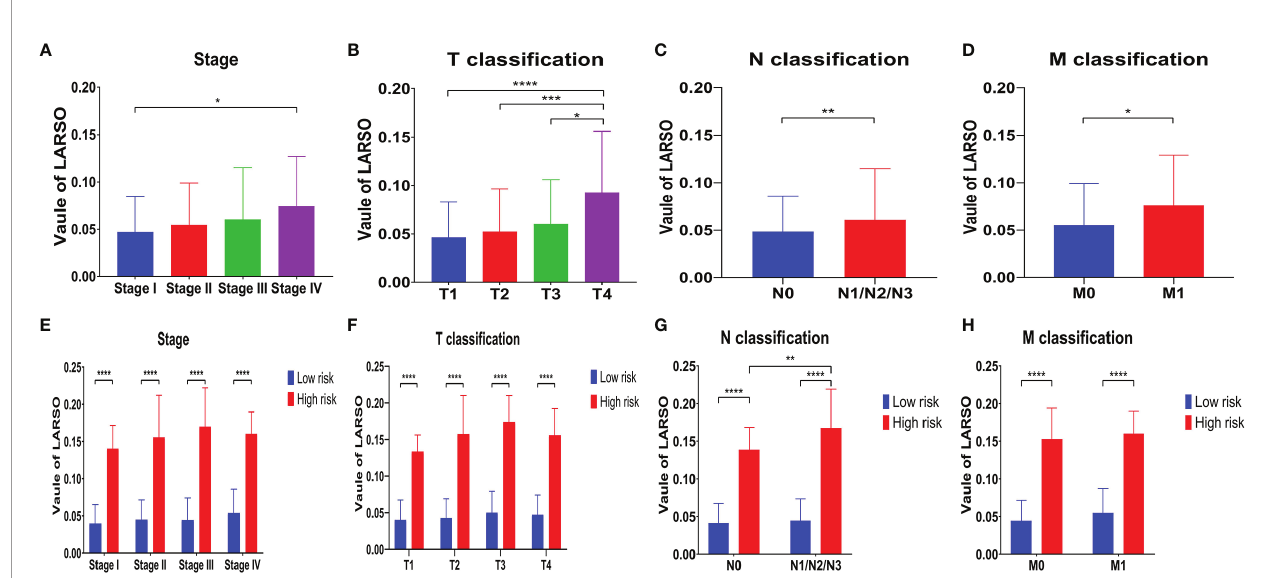
FIGURE 3 | Correlation analysis between the LARSO value and stage or TNM stage. (A) Tumor stage was negatively correlated with LARSO value, i.e., higher stage, lower LARSO value; the difference of LARSO between stage I and stage IV was statistically signi fi cant ( P < 0.05). (B) A higher LARSO value was associated with a worse T stage. The LARSO value at T1, T2, or T3 was statistically different from the LARSO value at T4. (C) The LARSO value of patients with lymph node metastasis (N1/N2/N3) was signi fi cantly higher than patients without lymph node metastasis (N0). (D) LARSO value in the M0 group was signi fi cantly lower than that in the M1 group ( P < 0.05). (E) The LARSO value between the high- and low-risk groups at different stages was statistically signi fi cant, and the LARSO value of the high-risk group was signi fi cantly higher than that of the low-risk group ( P < 0.05). (F) The LARSO value in different T stages between the high- and low-risk groups was statistically signi fi cant. (G) The LARSO value between the high- and low-risk groups was signi fi cantly different in various N stages ( P < 0.05). In addition, the LARSO value in the high-risk group with lymph node metastasis (N1/N2/N3) was signi fi cantly higher than that in the non-lymph node metastasis group (N0). (H) The difference of LARSO value in different M stages in the high- and low-risk groups was statistically signi fi cant. Student ’ s t -test was used for testing between groups. * P < 0.05; ** P < 0.01; *** P < 0.001; **** P <